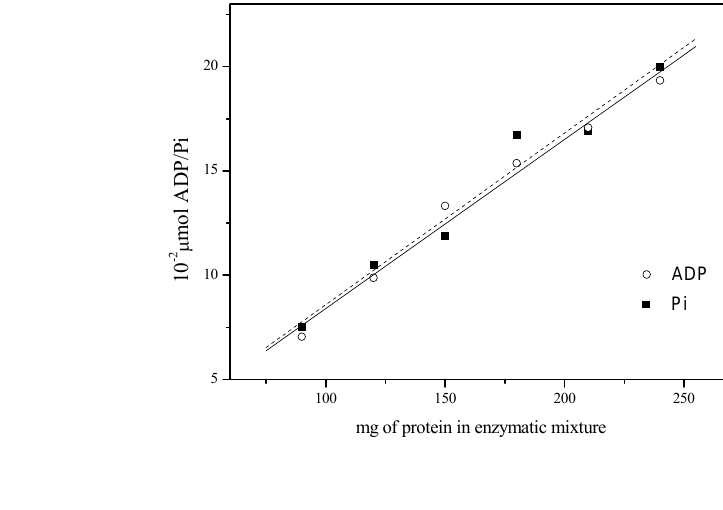
Figure 10. Chromatogram of 5 mM ATP hydrolysis products by using UPLC and comparison of UPLC and spectrophotometric determination of products of ATP hydrolysis catalyzed by Na + ,K + -ATPase. Reproduced from